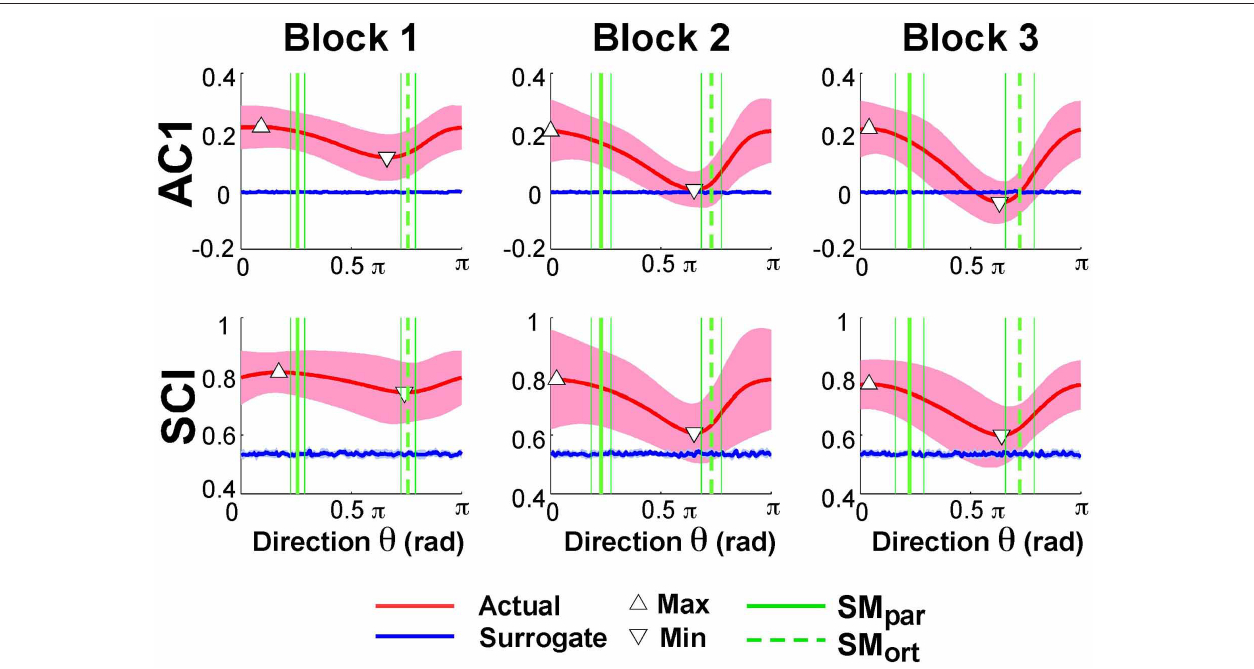
deviation around this mean. The triangles denote the minimum and maximum value of AC1 and SCI; the vertical green lines are the direction of the solution manifold with its variations across participants, denoted by the dashed lines. The horizontal blue lines are the results of the surrogate analyses.